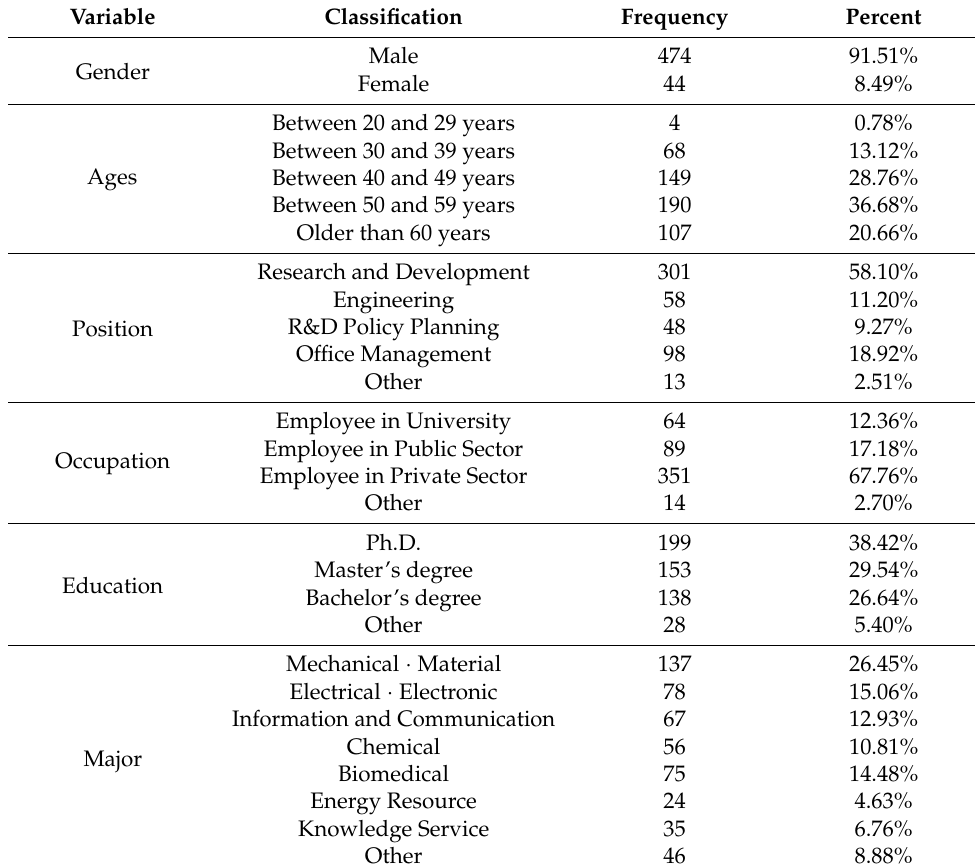
Table 1. Demographic information on